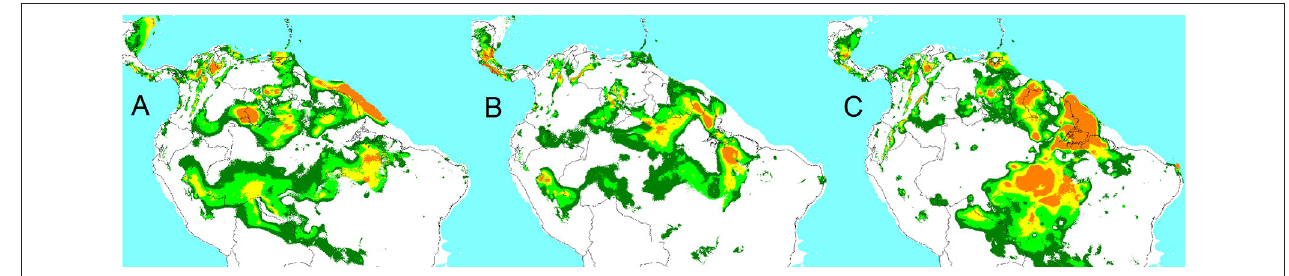
FIGURE 4 | Maxent-generated potential distribution models based on Last Glacial Maximum (A) CCSM4, (B) MIROC-ESM, and (C) MPI-ESM-P estimated climatic conditions for B. gasipaes var. chichagui types 1 and 2. Color code as in Figures 2B–D .